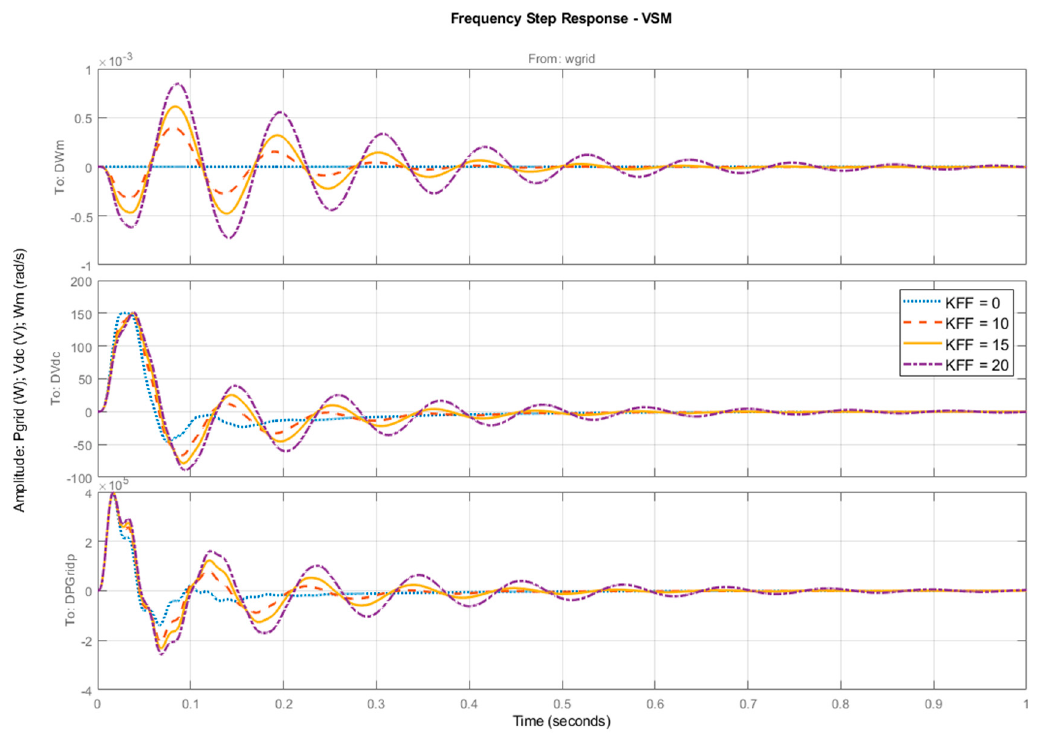
Figure 26. PVCCI Bode plot showing the effect of inertia feedforward to the generator.